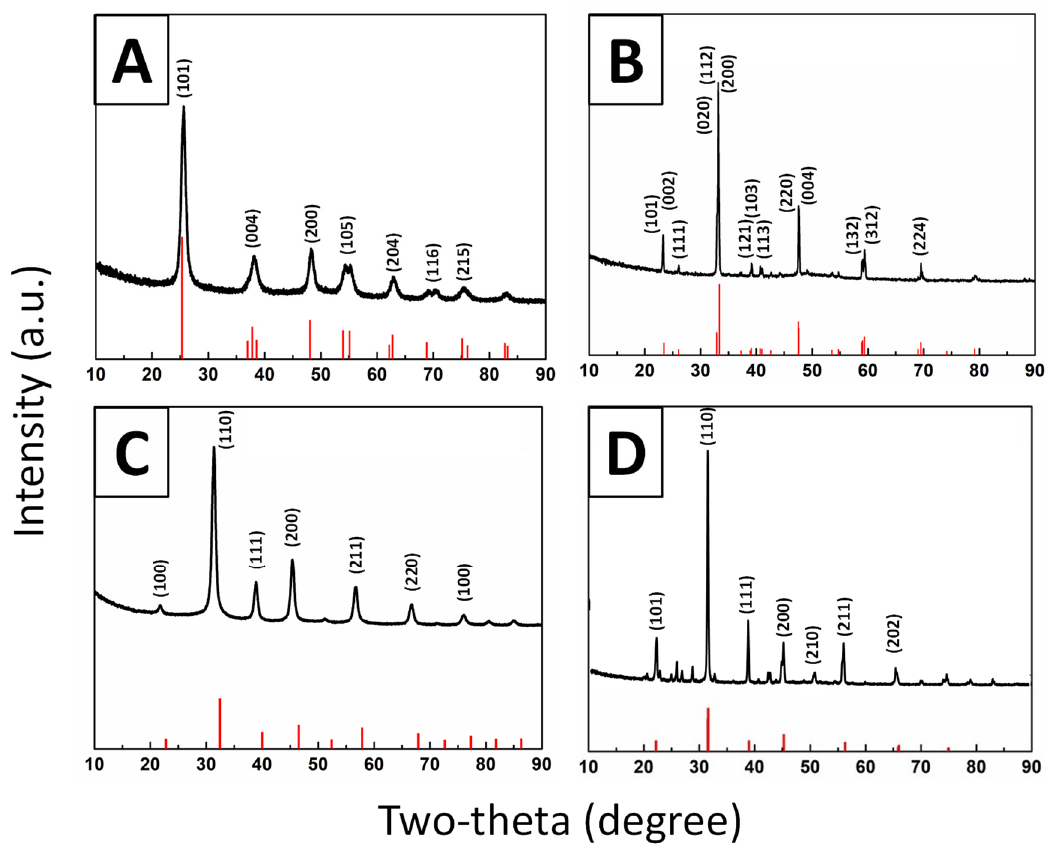
Figure 1. Indexed XRD patterns of ( A ) TiO 2 intermediate JCPDS #84-1286), ( B ) CaTiO 3 (CTO) sample (JCPDS #86-1393), ( C ) SrTiO 3 (STO) sample (JCPDS # 86-0179), and ( D ) BaTiO 3 (BTO) sample (JCPDS #74-1968) with a small BaTi 5 O 11 impurity.